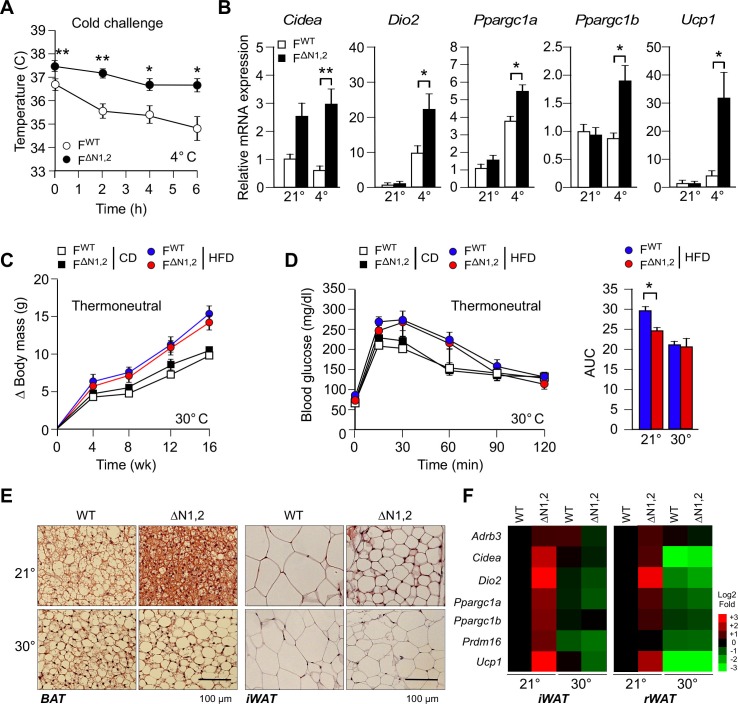
NOVA regulates a thermogenic program in adipose tissue.(A) FWT and F∆N1,2 mice were subject to cold challenge (4°C). Core body temperature was measured by telemetry using an implanted probe (mean ± SEM; n=8; *p<0.05; **p<0.01). The source data are included as Figure 5—source data 1. (B) The effect of cold challenge (4°C, 6 hr) on gene expression by inguinal adipocytes (iWAT) of FWT and F∆N1,2 mice was examined by quantitative RT-PCR (mean ± SEM; n=6~8; *p<0.05; **p<0.01). The source data are included as Figure 5—source data 2. (C) FWT and F∆N1,2 mice were housed under thermal neutral conditions (30°C). The change in body mass of CD and HFD-fed mice is presented (mean ± SEM; n=7~18). (D) Glucose tolerance tests were performed on FWT and F∆N1,2 mice housed under thermoneutral conditions (30°C). The effect of feeding a CD or a HFD (16 wk) is presented (mean ± SEM; n=8). The source data are included as Figure 5—source data 3. (E) Sections of brown adipose tissue (BAT) and iWAT of HFD-fed (16 wk) mice housed at 21°C and 30°C were stained with hematoxylin & eosin. The data shown are representative of 6 mice per group. (F) FWT and F∆N1,2 mice housed at 21°C and 30°C were fed a HFD (16 wk). Gene expression by adipocytes of iWAT and retroperitoneal adipose tissue (rWAT) was examined by quantitative RT-PCR (mean, n=8). The data are presented as a heat map.DOI:
http://dx.doi.org/10.7554/eLife.17672.03310.7554/eLife.17672.034Figure 5—source data 1.Source data for Figure 5A.DOI:
http://dx.doi.org/10.7554/eLife.17672.03410.7554/eLife.17672.035Figure 5—source data 2.Source data for Figure 5B.DOI:
http://dx.doi.org/10.7554/eLife.17672.03510.7554/eLife.17672.036Figure 5—source data 3.Source data for Figure 5D.